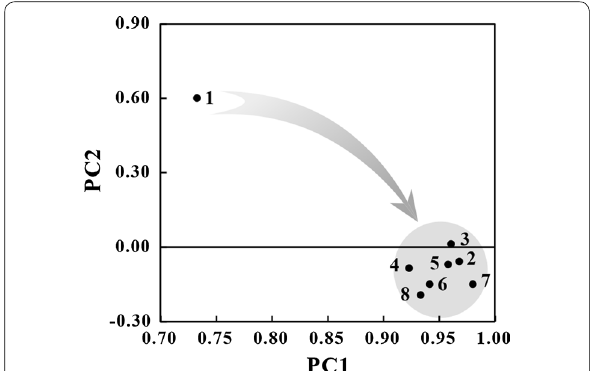
Fig. 4 Carbon metabolism principle component analysis of microbial community with different inlet VOCs: No. 1–8 referred to stages of toluene, ethylbenzene, chlorobenzene, acetone, isopropyl alcohol, ethyl acetate, n ‑hexane and